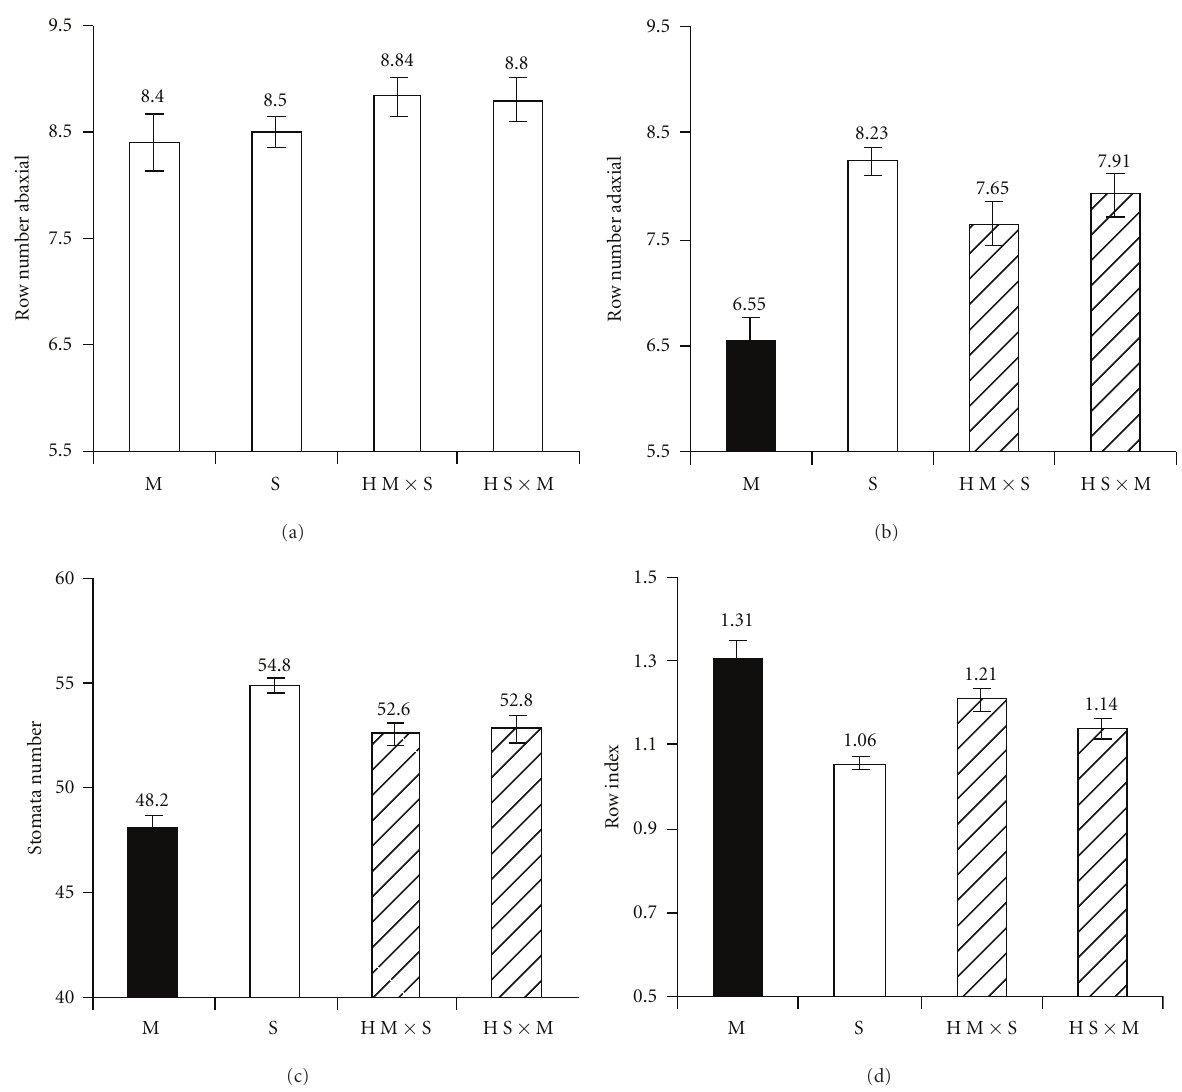
Figure 5: Species mean values for needle anatomy traits: stomata row number in the abaxial (a) and adaxial (b) needle surface; stomata number per 5mm stomata row (c); index of stomata rows (abaxial/adaxial). The species which were significantly di ff erent at 0.05 P level are filled with di ff erent pattern (based on Tukey LSD test in ANOVA). M is P. mugo (40 needles from 4 trees were studied); S P. sylvestris (240 needles from 24 trees); H M × S putative hybrids P. mugo × P. sylvestris (group B in Table 2; 110 needles from 11 trees studied); H S × M hybrids P. sylvestris × P. mugo (group A; 80 needles from 8 trees). The error lines indelicate the standard errors (calculated from needle level). Mean values are given above the bars.